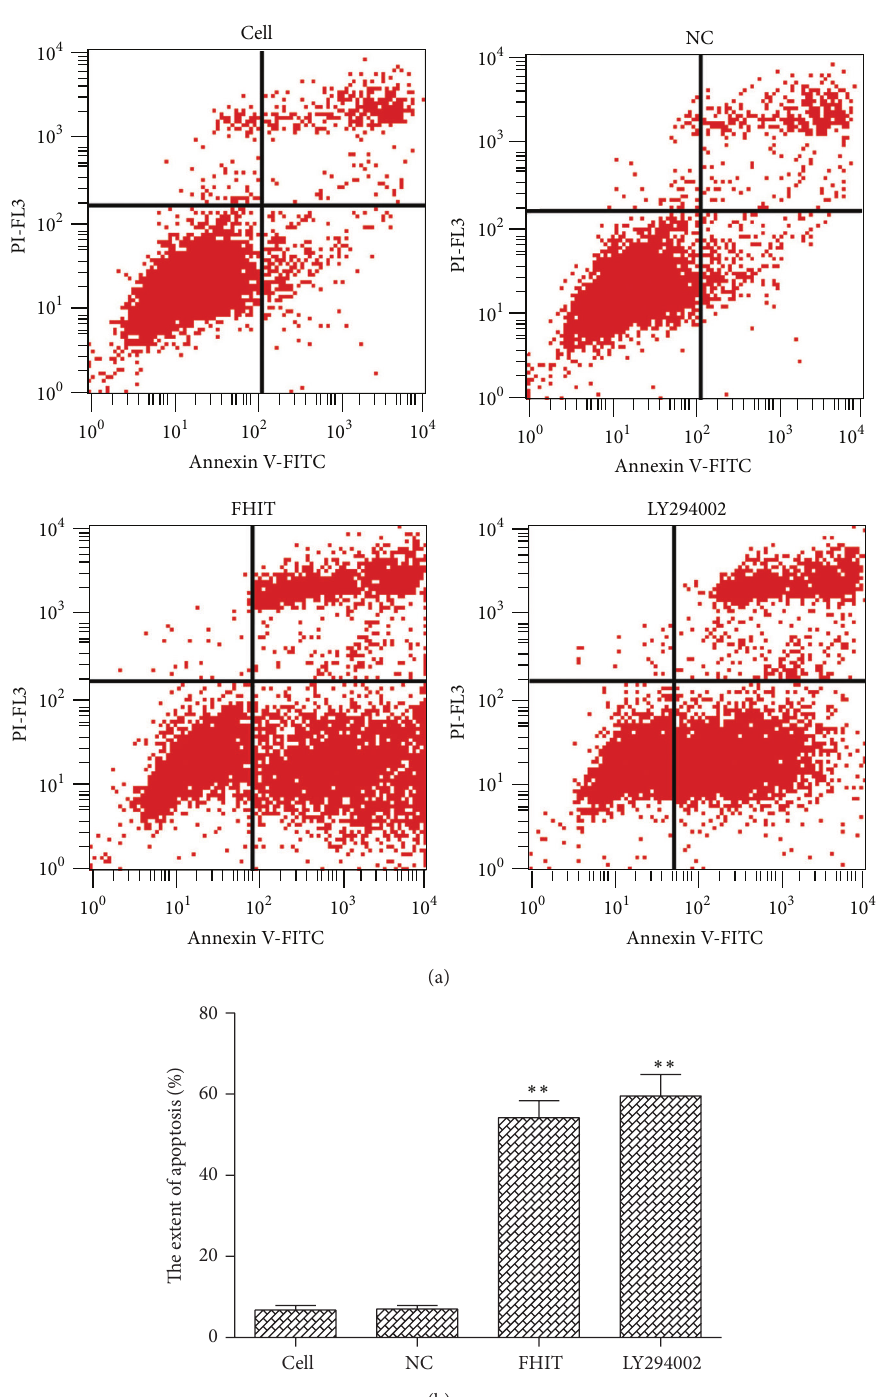
Figure 5: Apoptosis in each group was assessed after transfection or treatment with LY294002. Apoptosis was assessed after 48 h treatment with 20 𝜇 mol LY294002. ∗∗ 𝑃 < 0.01